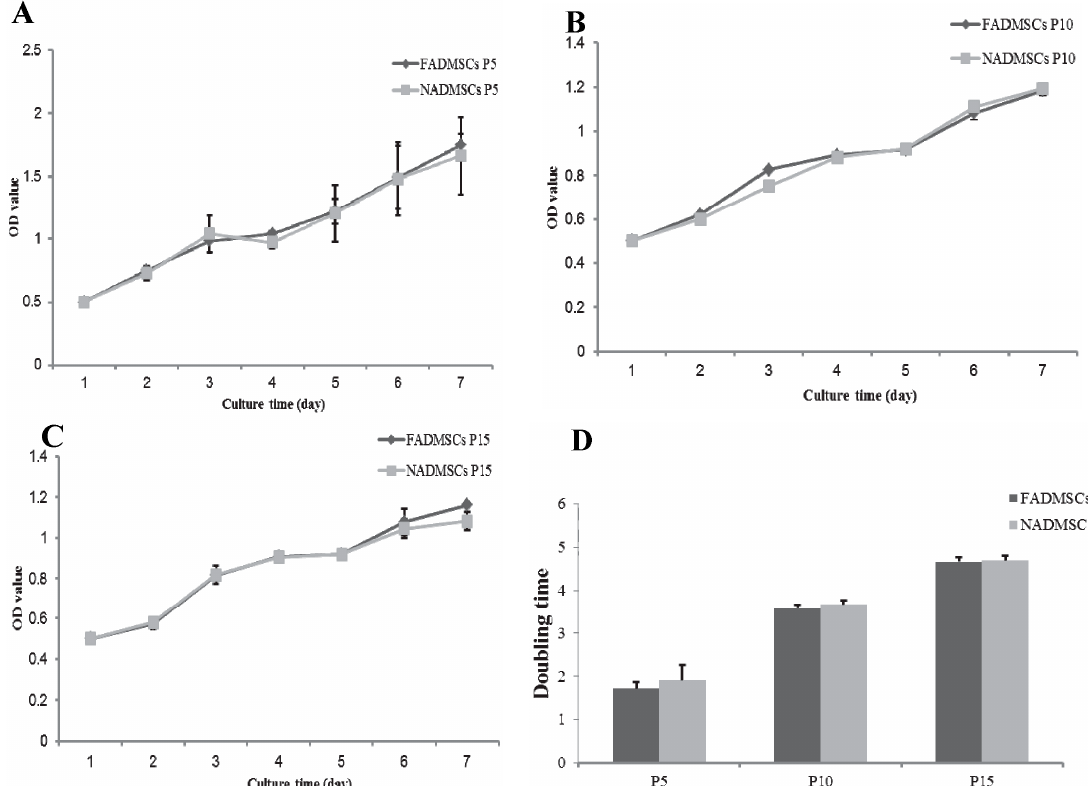
Figure 2. Comparison of the proliferative capacity between ALF-derived ADMSCs and normal ADMSCs. Measurements were performed based on water soluble tetrazolium salt (WST)-1 assays. The optical density (OD) value indicates the optical density at 450 nm. ( A ) Comparative analysis of cell proliferation between the two groups at passage 5; ( B ) Comparative analysis of cell proliferation between the two groups at passage 10; ( C ) Comparative analysis of cell proliferation between the two groups at passage 15; ( D ) Comparative analysis of the doubling time between the two groups at passages 5, 10 and 15. The results are representative of three independent experiments. Mean ± SD values are plotted.